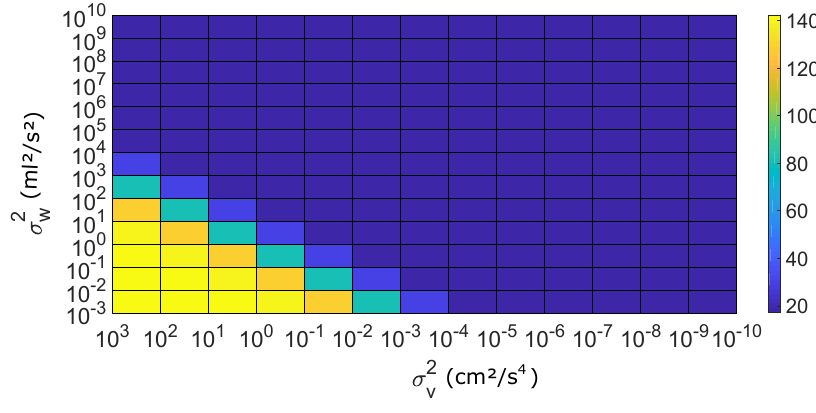
Figure 5. RMSE values for different combinations of σ 2 w and σ 2 v